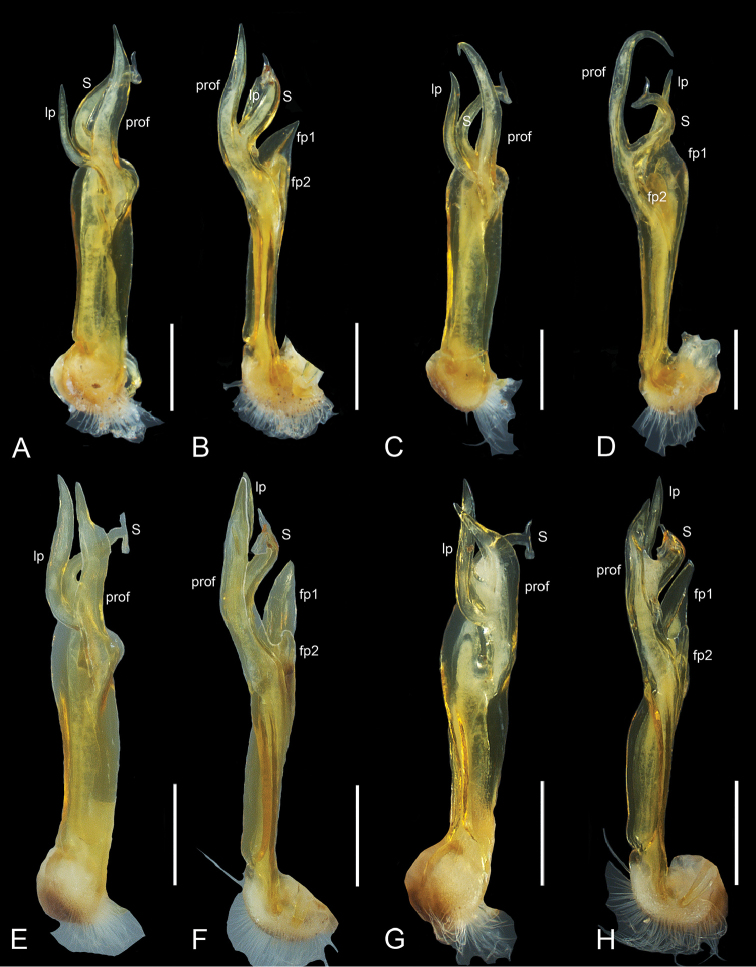
Pogonosternumnigrovirgatum (Carl, 1902), ♂, right gonopod. A, B AMS KS96017 Ferntree Gully C, DNMV K-10248 from Sandringham and Brighton. Pogonosternumjeekeli Decker, sp. n., ♂, right gonopod E, FNMV K-10252 from Dyer Creek G, HNMV K-10250 from Bemm River. A, C Posterior view B, D Mesal view. Scale bar: 0.5 mm.